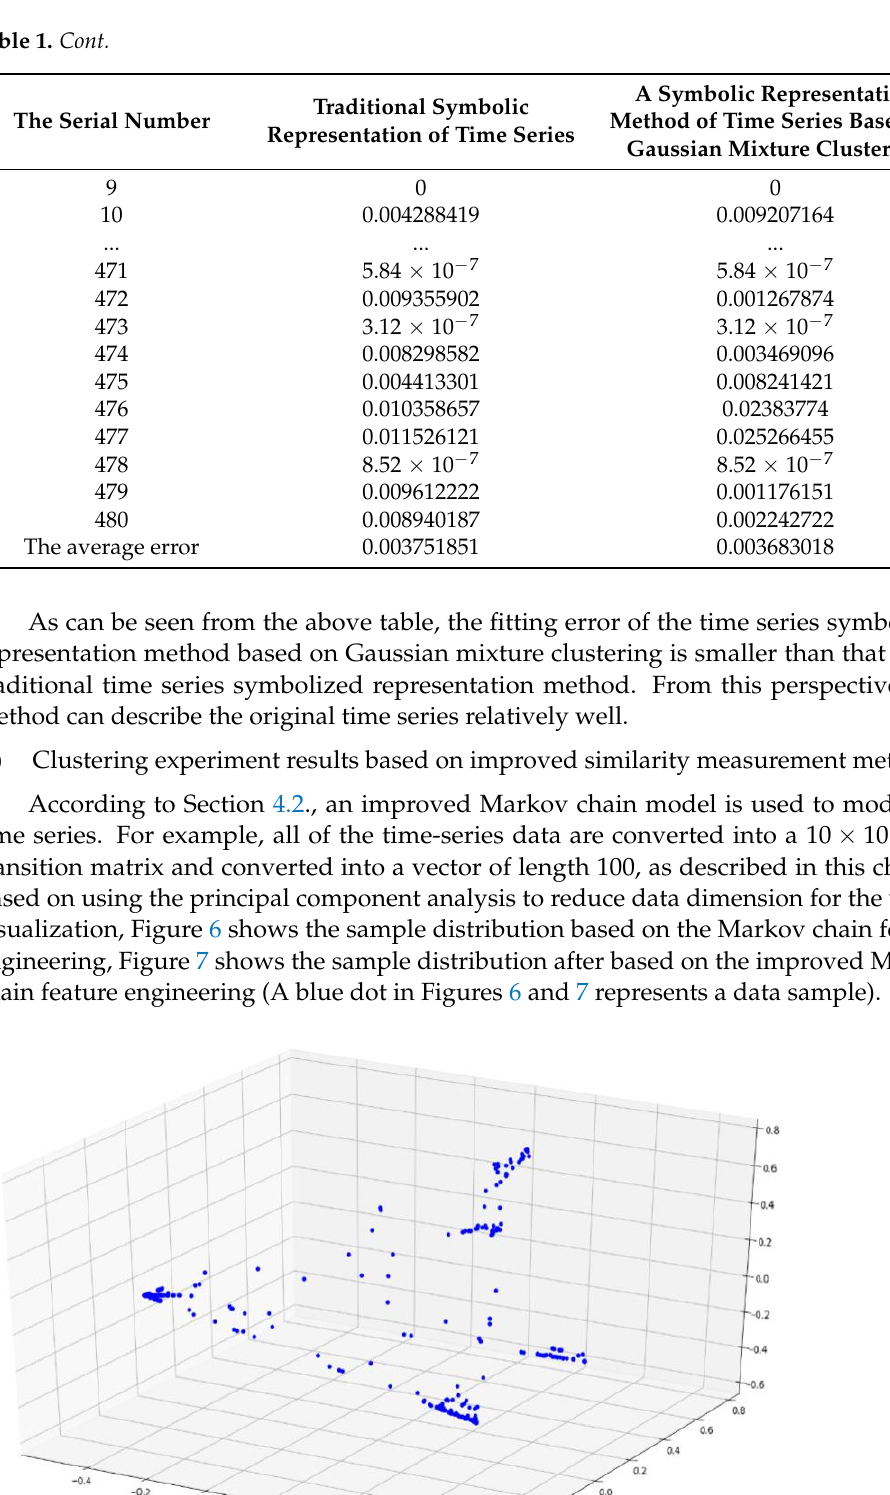
Figure 6. Sample distribution based on the Markov chain feature engineering.